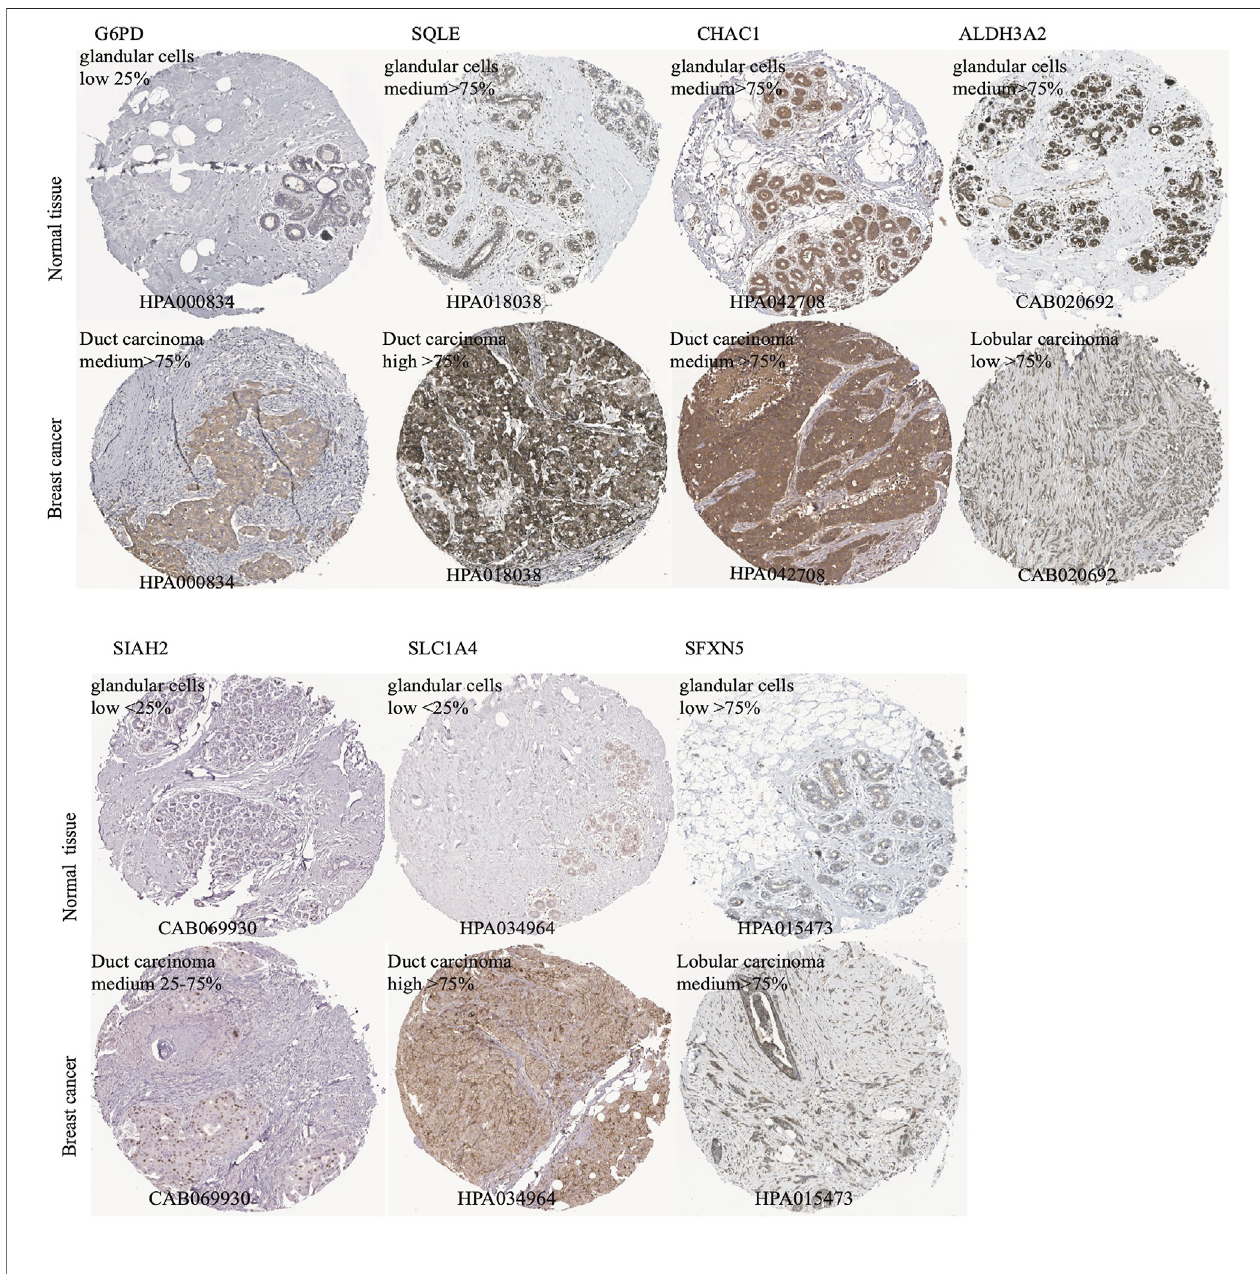
FIGURE 7 | The immunohistochemistry (IHC) of ferroptotic prognostic protein images from the HPA database. The G6PD, SQLE, CHAC1, ALDH3A2, SIAH2, SLC1A4, and SFXN5 proteins level in breast cancer and adjcent normal tissues were shown by the IHC staining.